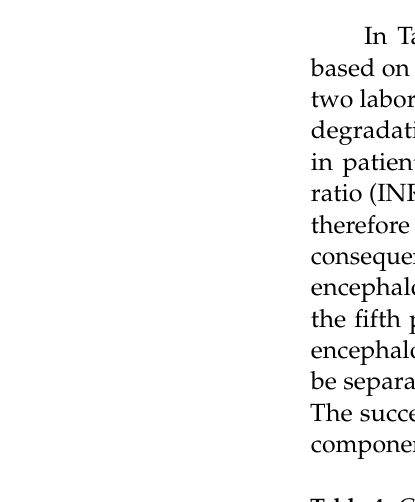
Table 4. Classification rate (in %) of the clinical parameters that achieved an overall accuracy for discriminating the groups greater than